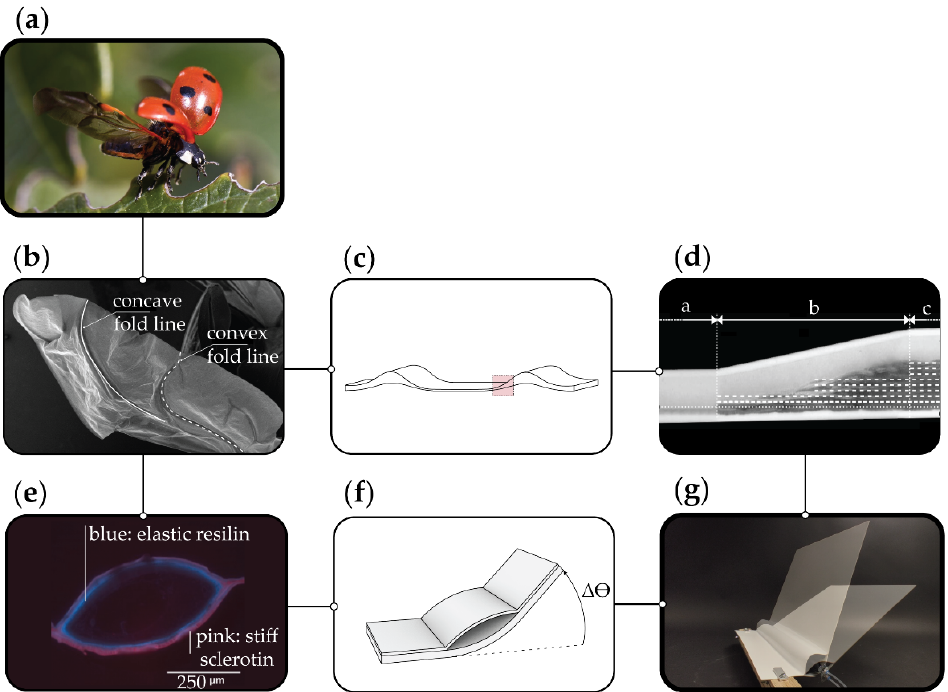
Figure 1. Biomimetic abstraction process with ( a ) biological role model Coleoptera coccinellidae [10], ( b ) scanning electron microscope image of the hindwing [11], ( c ) schematic of the material cross section in the insect wing (adapted from [7]), ( d ) hybrid FRP with graded material transitions between stiff and flexible zones [12], ( e ) autofluorescence image of the hollow vein in insect wing with marked sclerotin (pink) and resilin (blue) (adapted from [7]), ( f ) abstracted actuation principle with stiffer (bottom) and less stiff laminate and ( g ) FRP combining both principles (material and actuation).